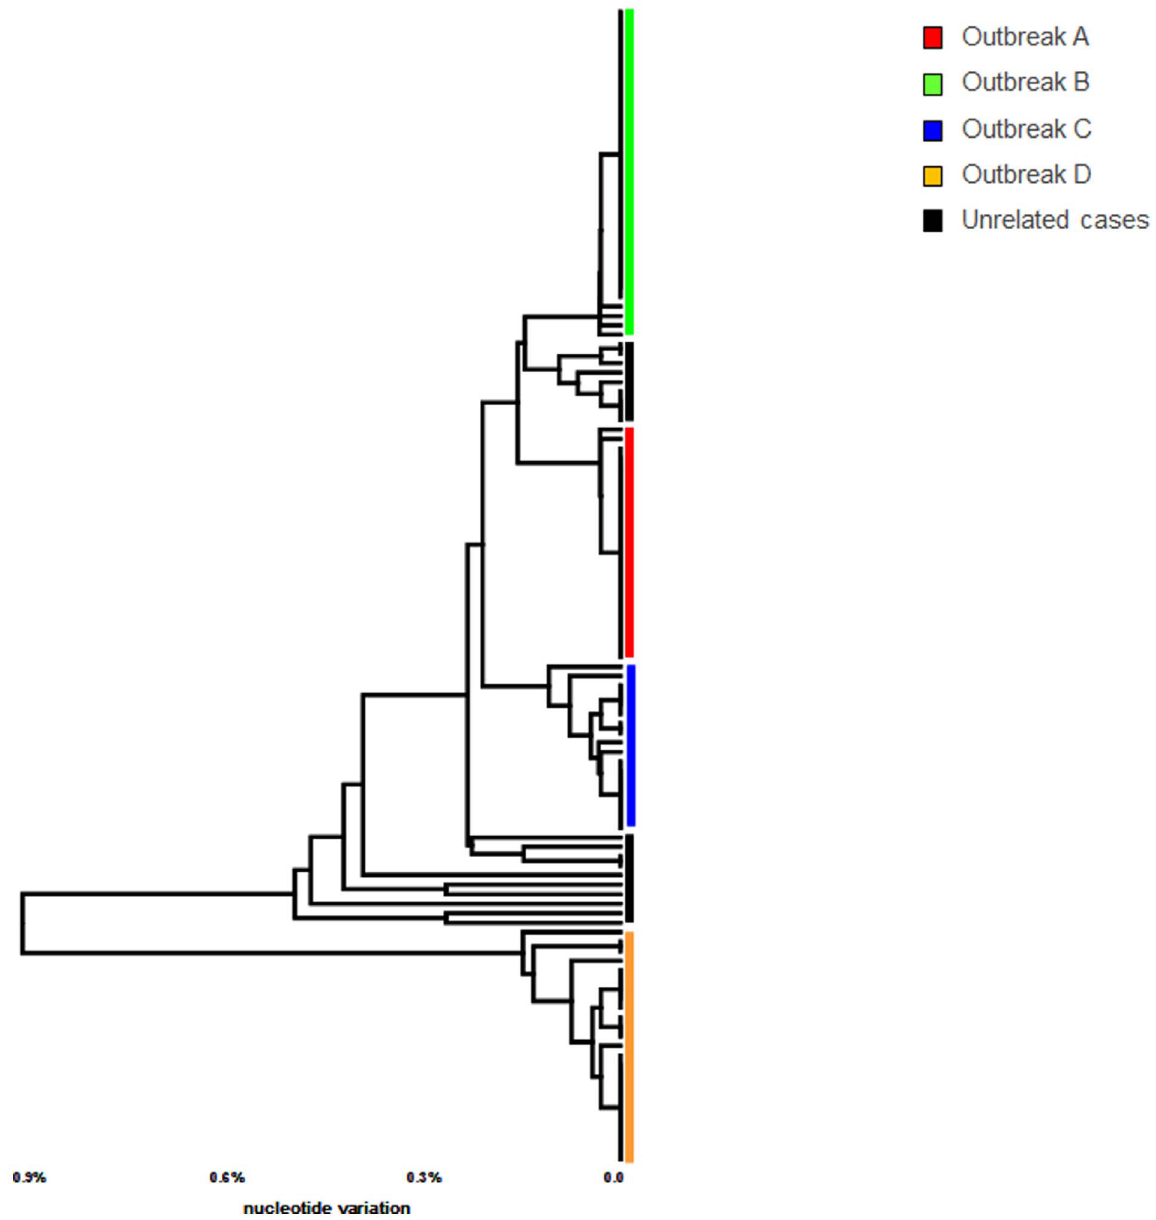
Figure 7. Phylogenetic analysis of VP1-P2C region from outbreak and sporadic HAV strains. Phylogenetic analysis of the HAV VP1-P2C region was performed using all HAV outbreak strains. Samples belonging to each outbreak are color